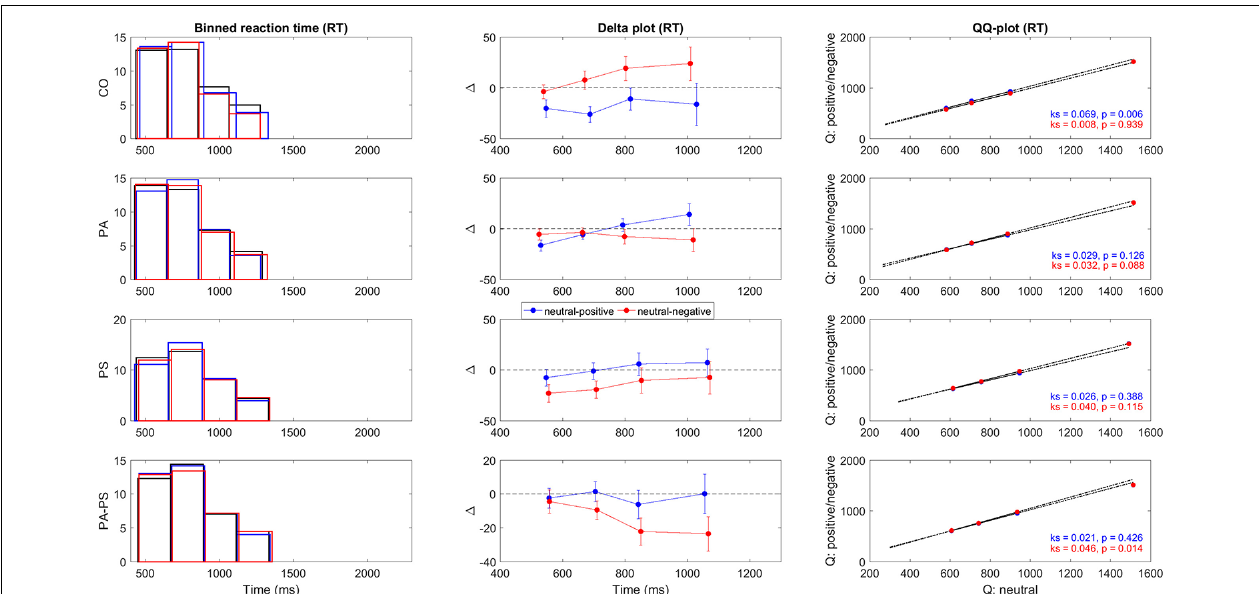
FIGURE 2 | Delta plots RT. Illustration of the quantile differences in RT per group (CO, PA, PS, PA-PS). First panel: Binned RT frequency distributions for the neutral (black), positive (blue), and negative (red) condition. The solid lines indicate edges of the four bins. Second panel: Delta plots of quantile differences ( y -axis, i.e., neutral minus positive, and neutral minus negative) against quantile averages ( x -axis), as computed from the cumulative distribution functions (CDFs). Note the different y -units between RT and RT slow ( Figure 3 ), adapted for better visibility. See Tables 3 and 4 for statistical analysis. Third panel: QQ-plots of the frequency distributions between the neutral versus the positive (blue) and negative (red) conditions. Statistical significance was assessed using two-sample Kolmogorov–Smirnov test ( k , p -value) comparing the CDFs of the neutral versus the positive and negative conditions.